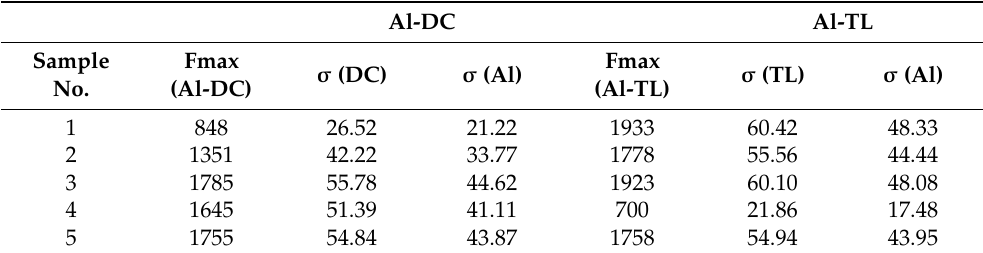
Table 8. Maximum load Fmax [N] and stress σ [MPa] in substrates.